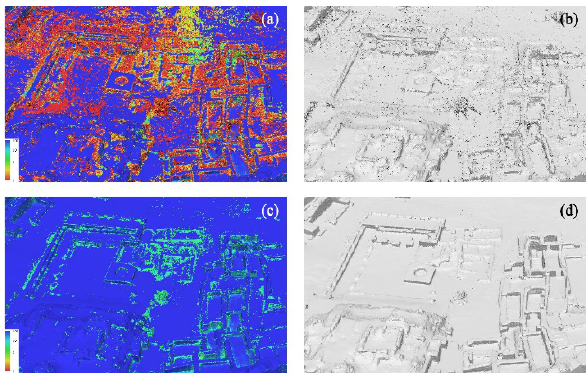
Figure 14. UAV photogrammetric point cloud analysis based on the confidence level. (a) and (b) point cloud before the optimisation; (c) and (d) point cloud after the optimisation.